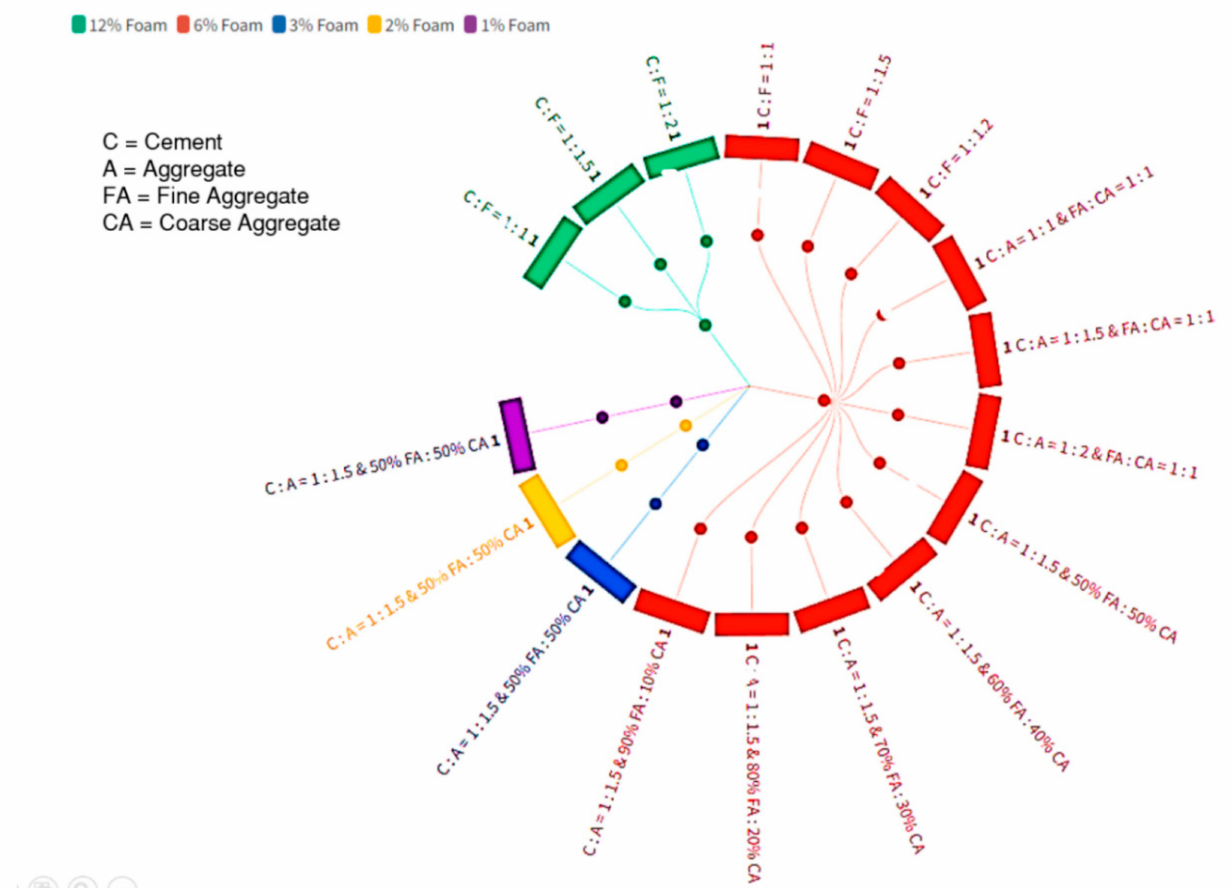
Figure 2. Radial Diagram of Mix